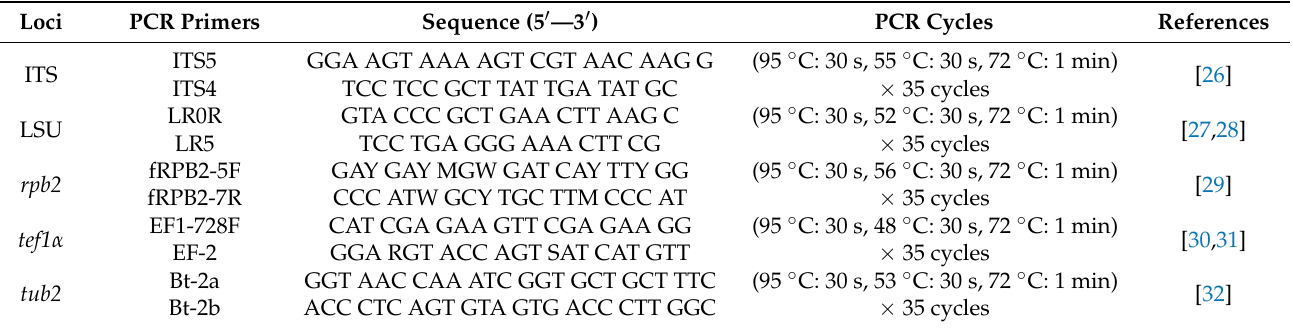
Table 1. Molecular markers and their PCR primers and programs used in this study.